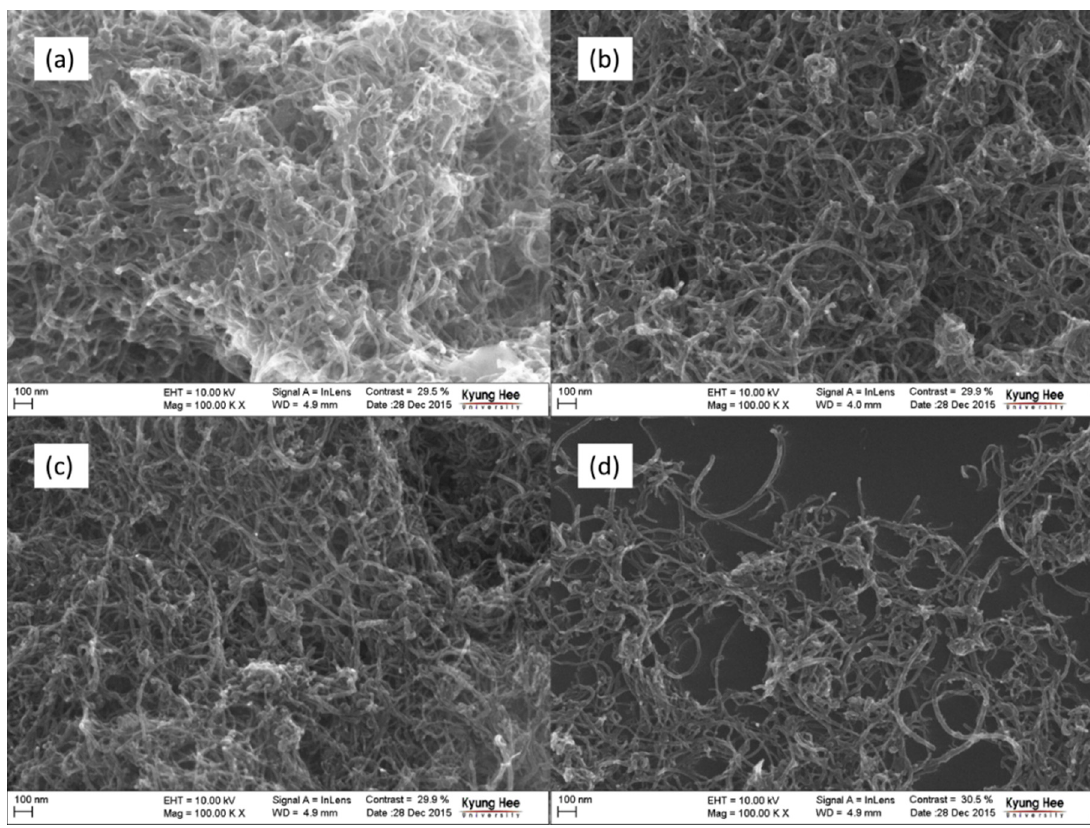
Figure 2. FE-SEM images of CNTs: ( a ) RCNT; ( b ) Cr-20-5; ( c ) Cr-20-10; and ( d ) Cr-20-15. The sample Cr-20-15 shows less agglomeration, more dispersion, shorter tube length, and more amorphous carbon in comparison to the others.